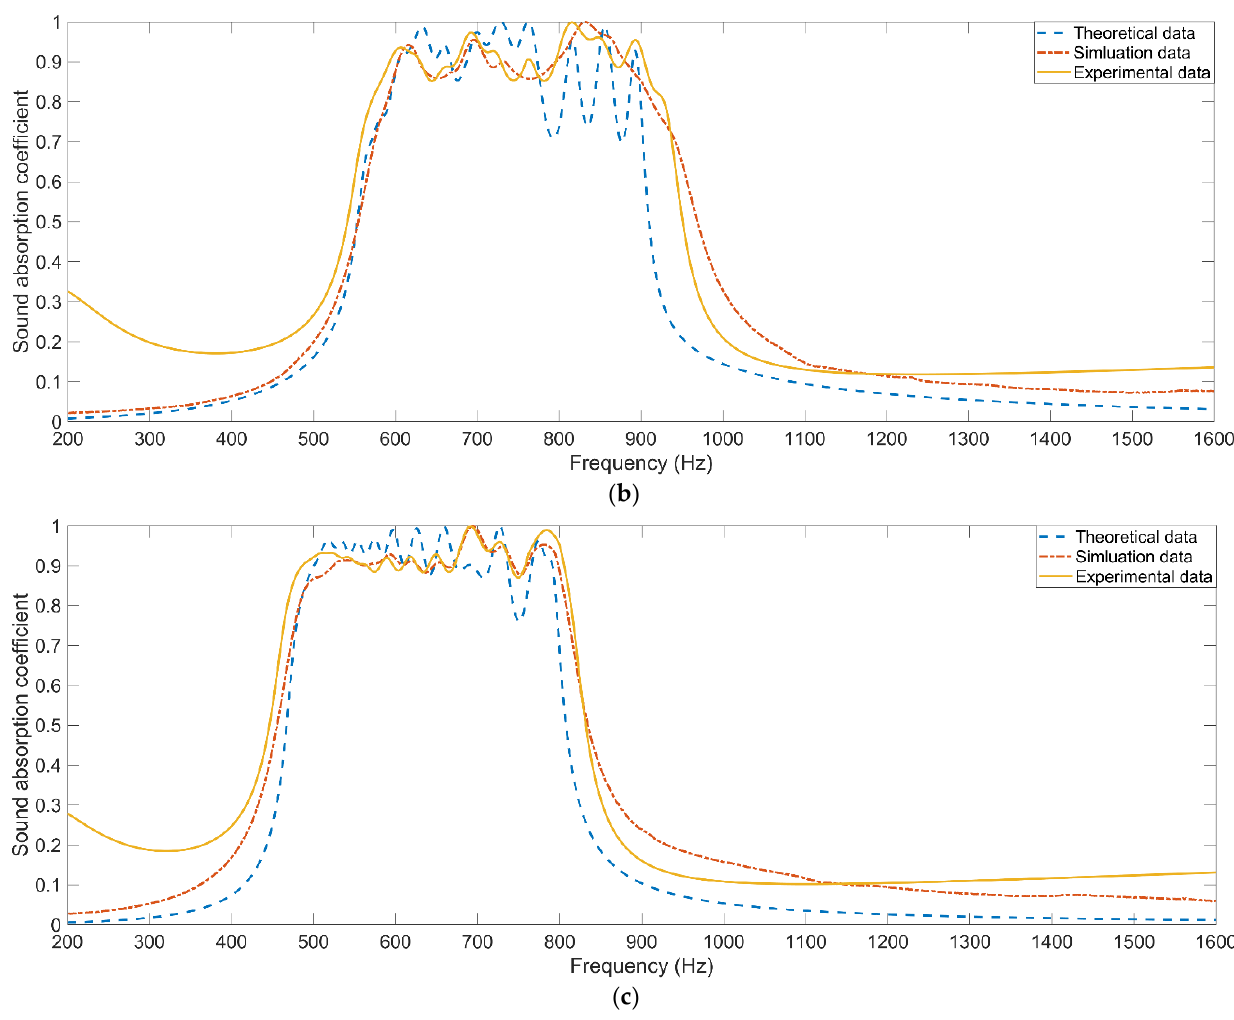
Figure 11. Comparisons of sound absorption coefficients of the 3 optimized metamaterial cells in theory, in simulation and in actual: ( a ) Condition − 1; ( b ) Condition − 2; ( c ) Condition − 3.